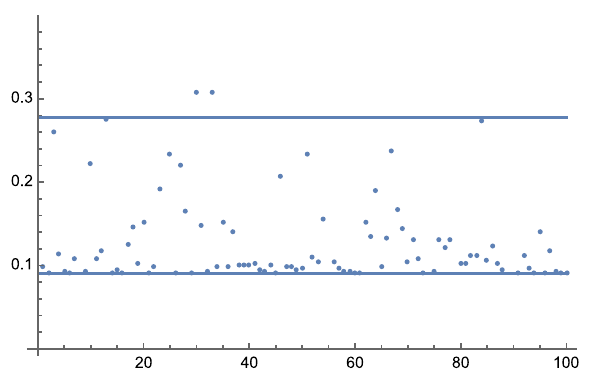
Fig. 9 The variances V [ F ] of Example 3 computed for 100 independent executions with 4 Newton–Raphson iterations for the Kullback–Leibler divergence exploiting 50 samples in each iteration. The horizontal lines correspond to the optimal and the equal sampling budget variances, respectively